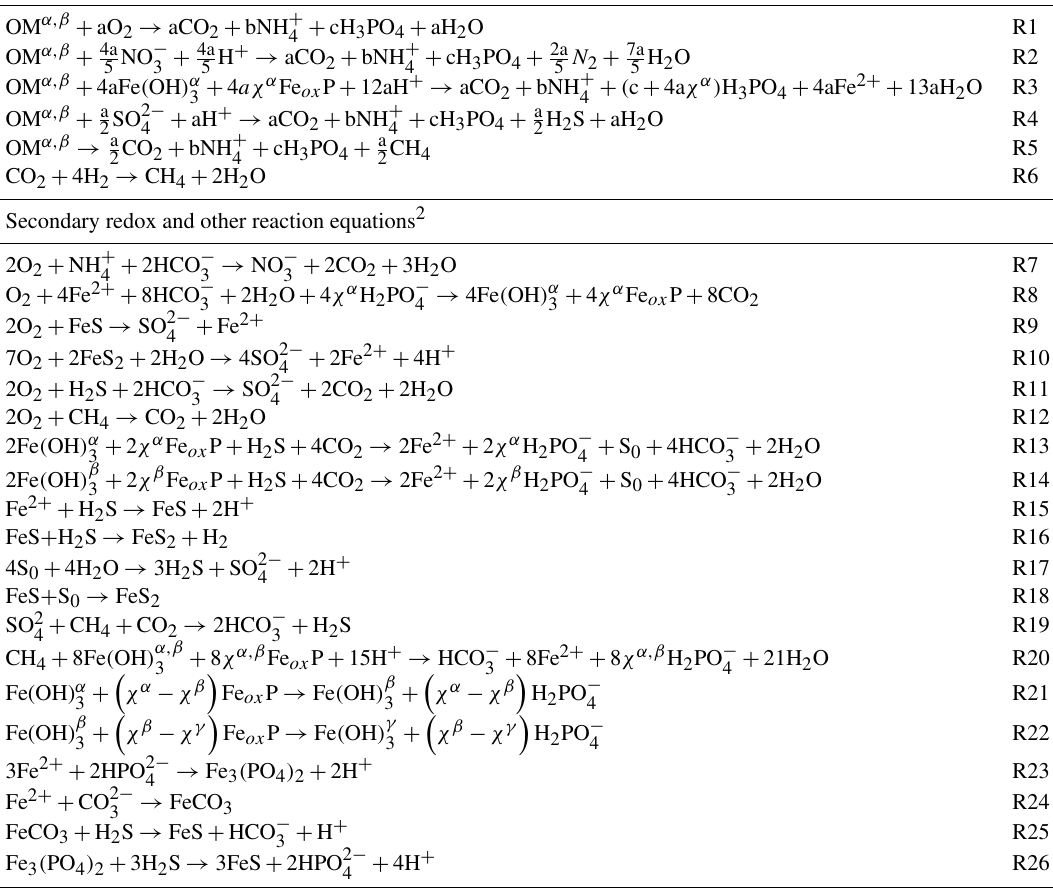
Table 3. Reaction pathways and stoichiometries implemented in the diagenetic model. Primary redox reactions